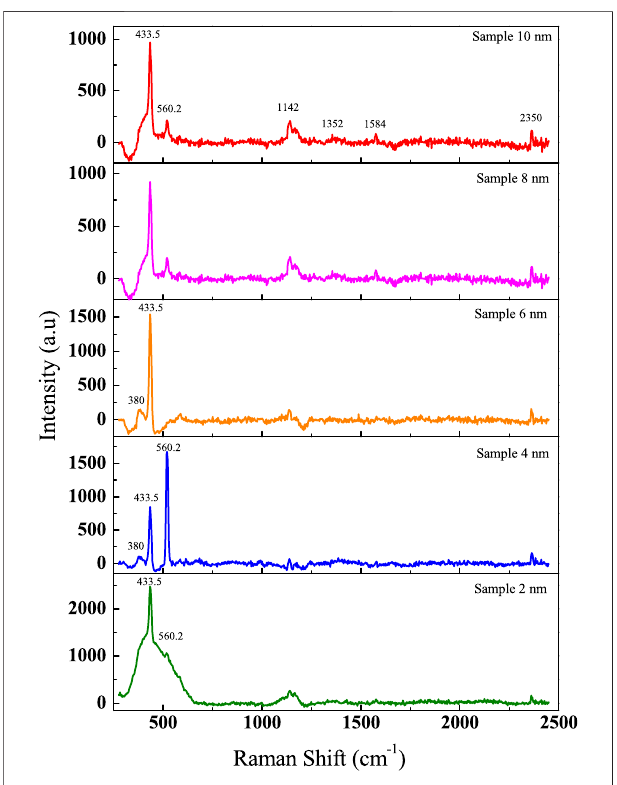
FIGURE 10 | Raman spectra of unannealed Au layer with various thicknesses on the Si